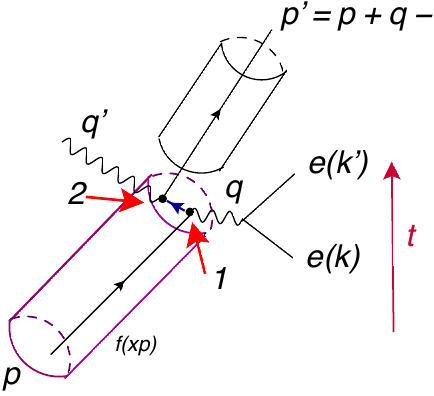
Figure 4: The process encoded in a generalized parton